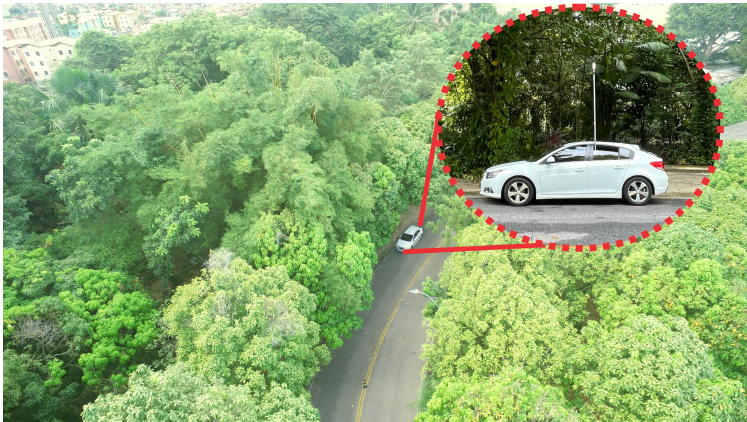
Figure 4. Vehicle in